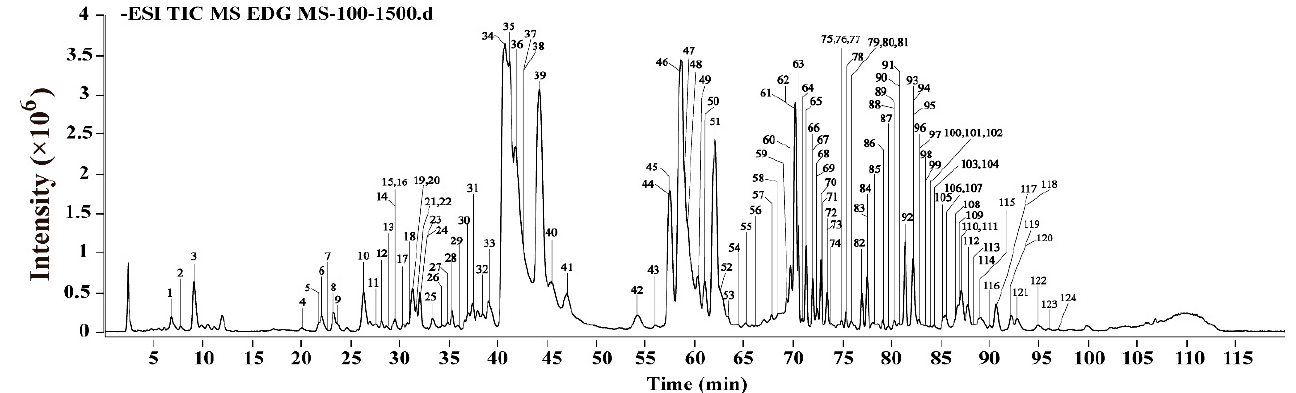
Figure 1. The total ion chromatograms (TICs) of EDG obtained with HPLC ‐ Q ‐ TOF/MS in negative ion mode.